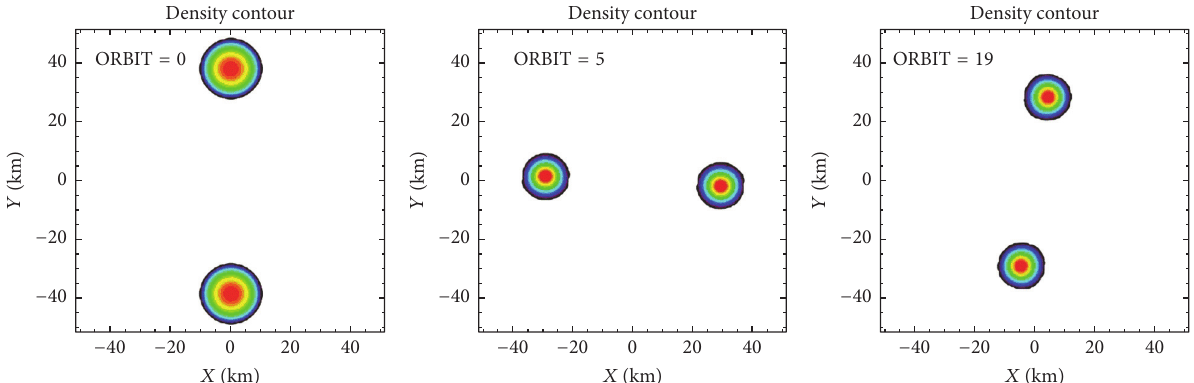
Figure 6: Contours of the central density for the binary system at the approximate number of orbits as labelled.